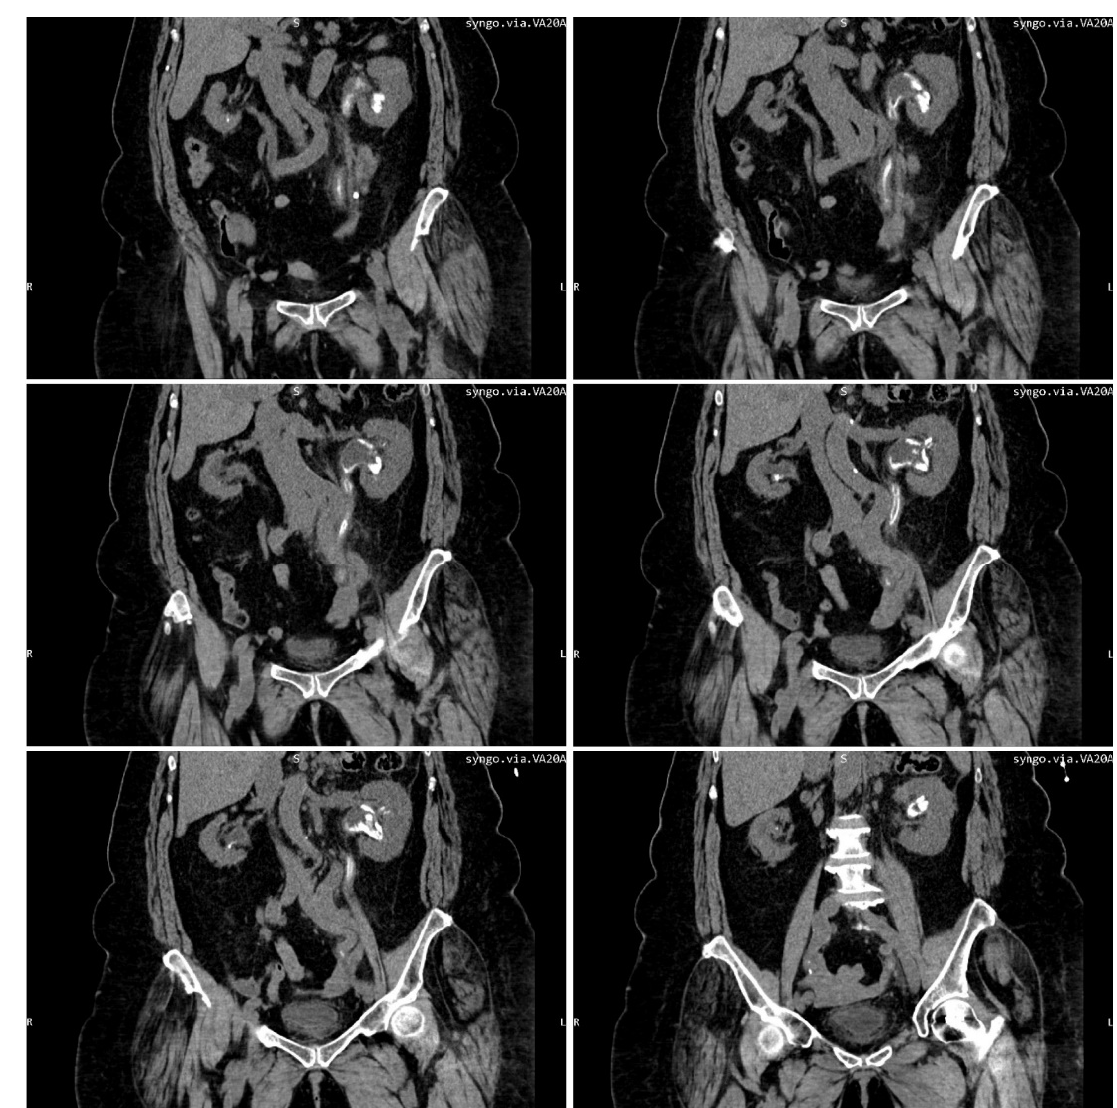
Figure 2. Multiplanar reconstruction of abdominal and pelvic CT scans without contrast shows multiple ureteral, pyelic, and calyceal encrustations.